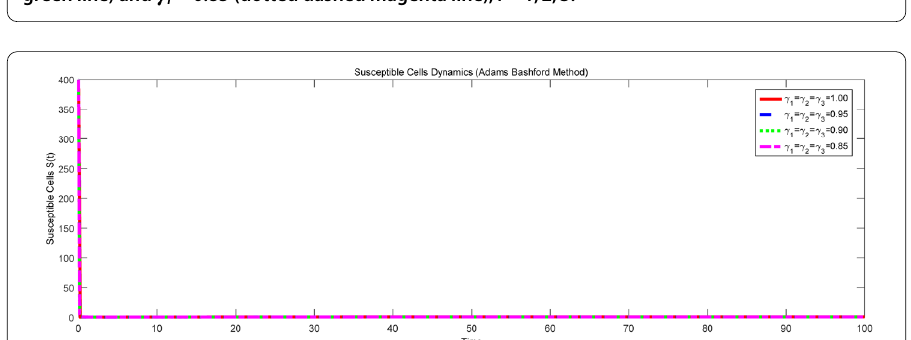
Figure 4 Dynamics of V ( t ) with γ i = 1 (solid red line), γ i = 0.95 (dashed blue line), γ i = 0.9 (dotted green line) and γ i = 0.85 (dotted dashed magenta line), i = 1,2,3.